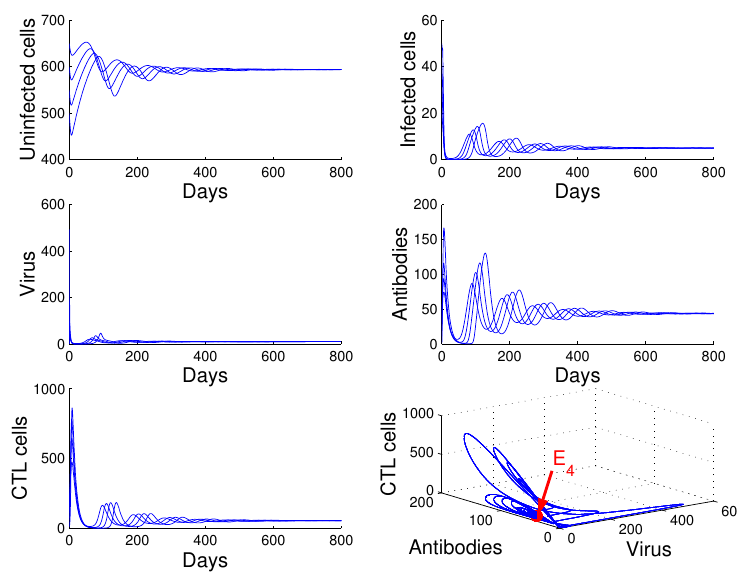
Figure 5. Demonstration of the global stability of the infection equilibrium with both arms of immunity = 1.8783 > 1, and R W = 8.2918 > E 4 for R 0 = 2.2923 > 1, R Z 2 3